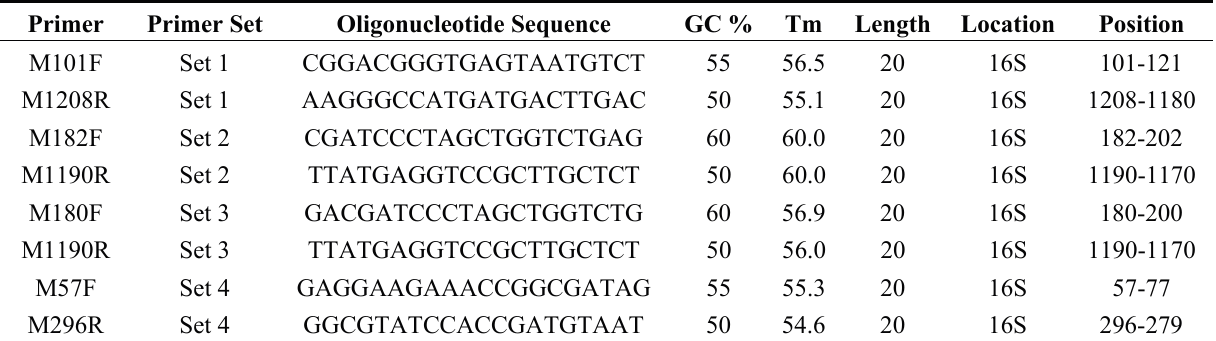
Table 1. Primers